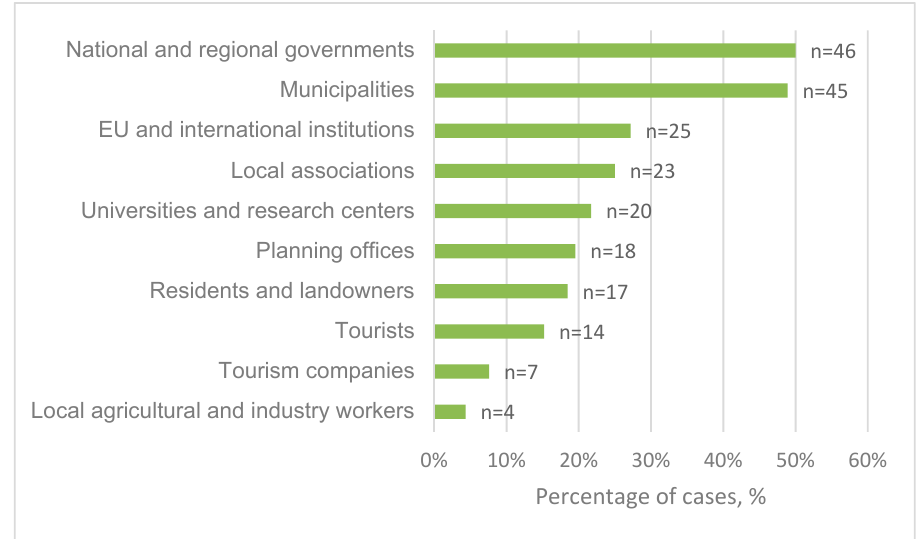
Figure 7. Stakeholder involvement in landscape corridor planning and management, by stakeholder type.